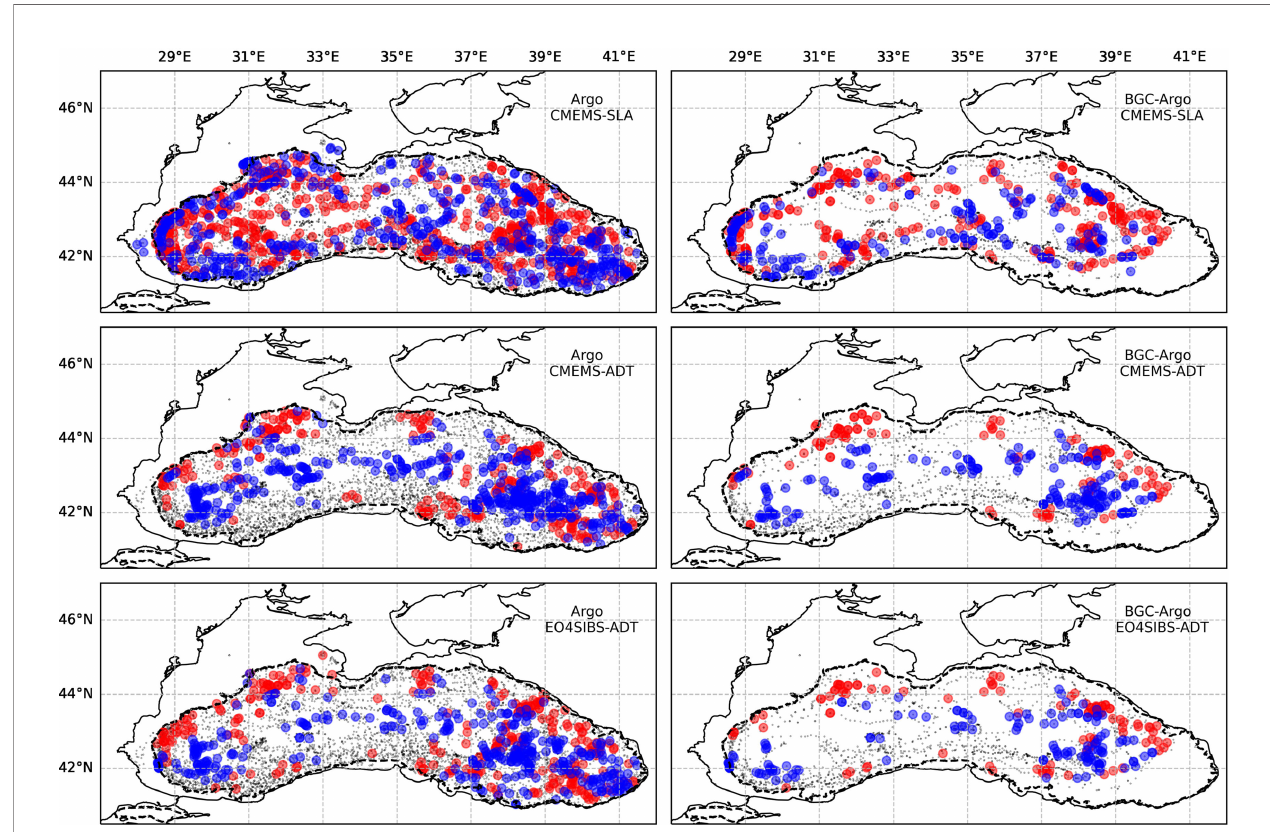
FIGURE 3 | Location of the (left) Argo and (right) BGC-Argo pro fi les. Match-ups obtained with different altimetric product are highlighted for (blue) cyclones and (red) anticyclones. The dotted line indicates the 200m isobathymetric